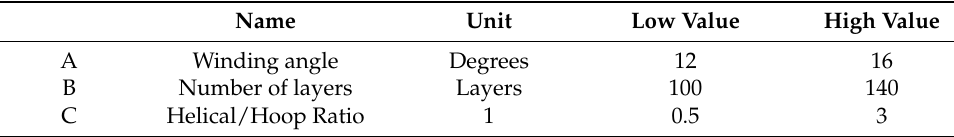
Table 4. Box–Behnken design proposal.